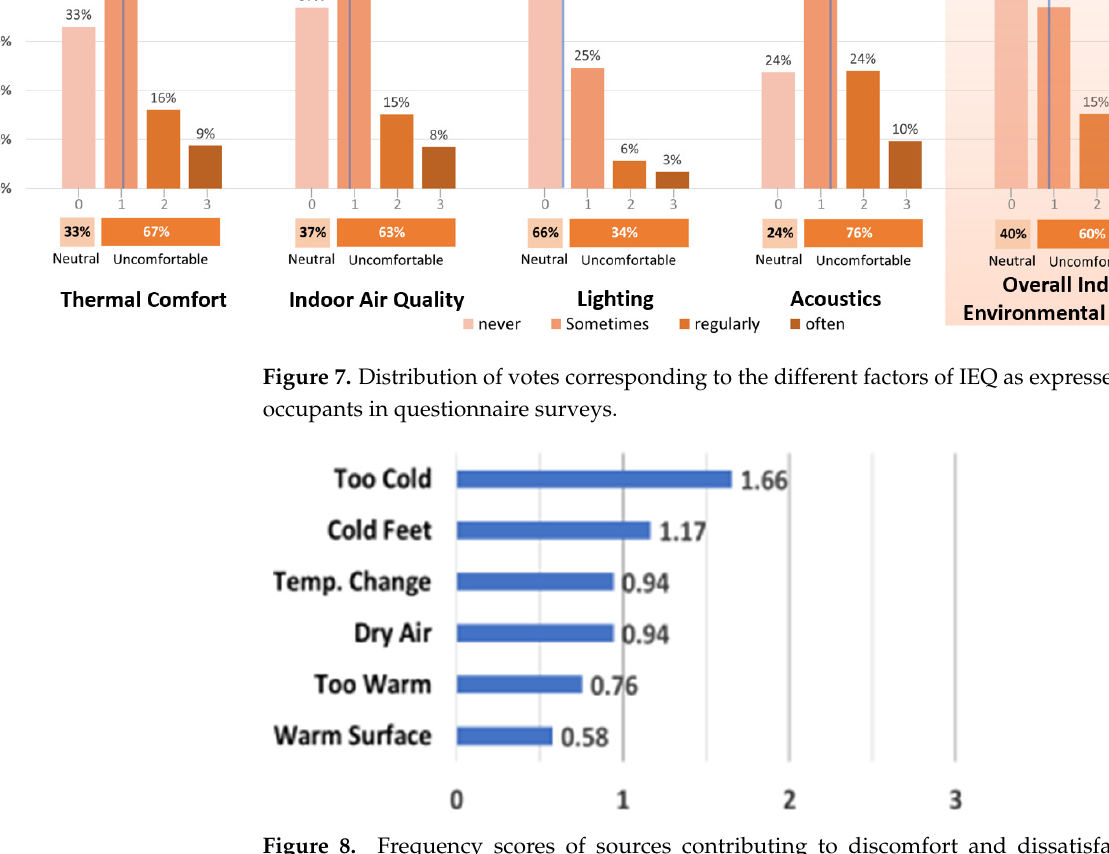
Figure 9. Sensitivity analysis of most common health-related symptoms caused by the Indoor Envi- ronment Quality.